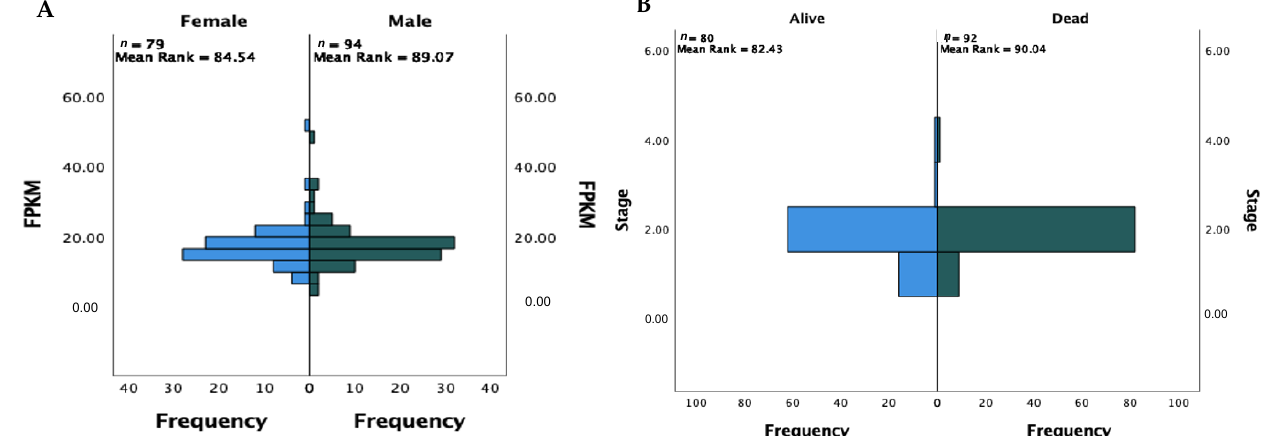
Figure 3. Population pyramids showing the results of an independent samples Mann–Whitney U test of difference on: ( A ) FPKM expression against patient sex in a cohort of 173 pancreatic ductal adenocarcinoma patients. No significant difference was observed between the groups ( U = 3518.5, p = 0.553). ( B ) Patient stage against alive/dead status in a cohort of 172 pancreatic ductal adenocarcinoma patients. No significant difference was observed between the groups ( U = 4005.5, p = 0.119).